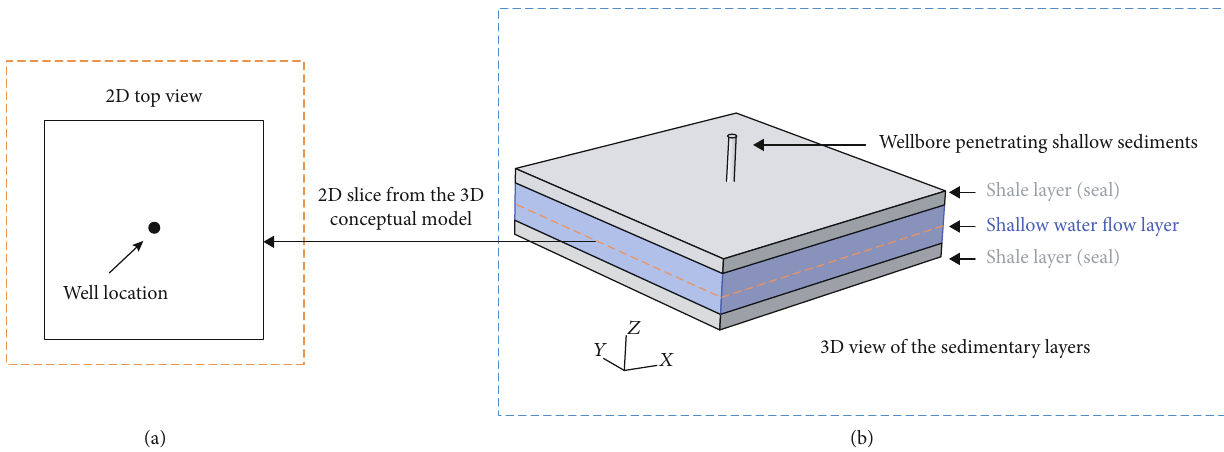
Figure 3: (a) 2D domain of the numerical model in this study and (b) 3D conceptual model of the target area. Table 3: Parameters for the base case of the numerical